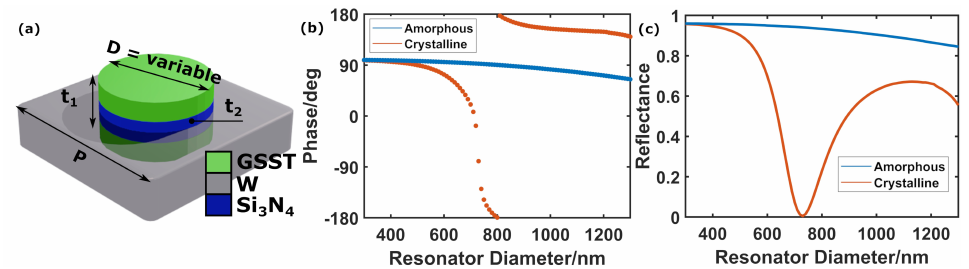
Figure 2. ( a ) Schematics of the mid-IR unit cell or meta-atom. Optimum geometrical parameters after optimisation were found to be p = 1400 nm, t 1 = 179 nm and t 2 = 8 nm. ( b ) Dependence on resonator diameter of the phase imparted by the meta-atom on reflected light. ( c ) Dependence on resonator diameter of the meta-atom